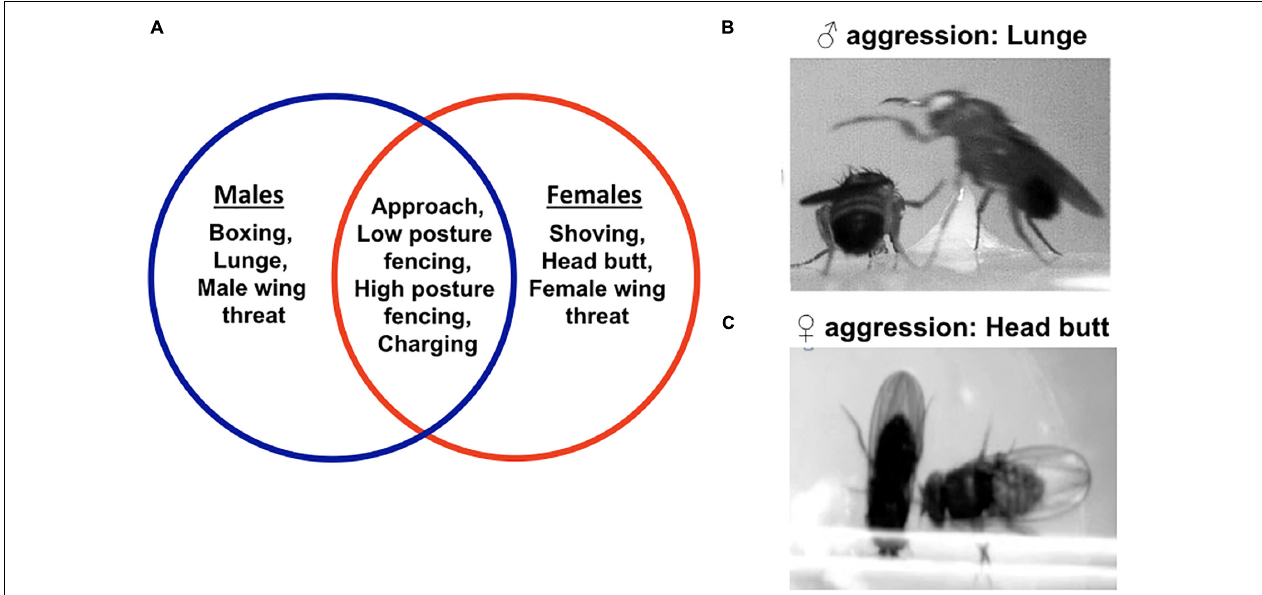
FIGURE 1 | Motor programs used in fruit fly aggression. The Venn diagram shows the different motor programs used in male and female aggression. Some of the motor programs are sexually dimorphic. The motor programs encircled in blue are specific for male aggression. The motor programs encircled in red are specific to female aggression. The intersection enlists the motor programs common to both male and female aggression (A) . The most consistent motor program in male aggression is a lunge (B) . In a lunge, a male fly stands on its hind legs and snaps down on its opponent. The most consistent motor program in female aggression is a head butt. In a head butt, the female fly extends her torso and strikes the opponent with her head (C)